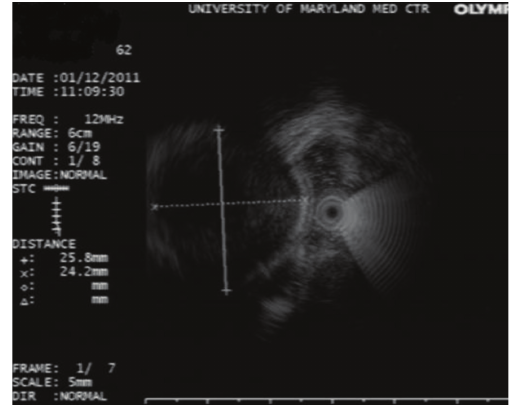
Figure 2: EUS image showing an anechoic structure within the appendix in Case 1.